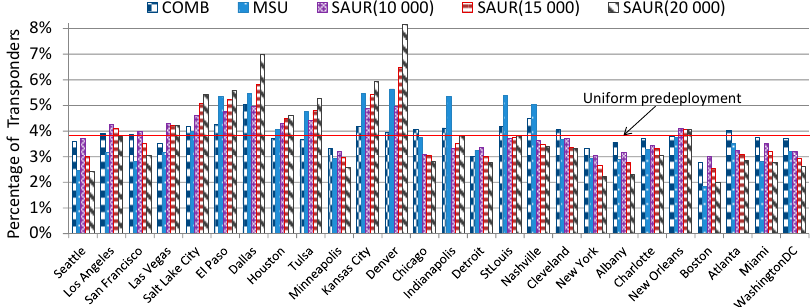
Figure 8. Placement of transponders in nodes of network US26 for traffic profile TP A as a function of various algorithms.